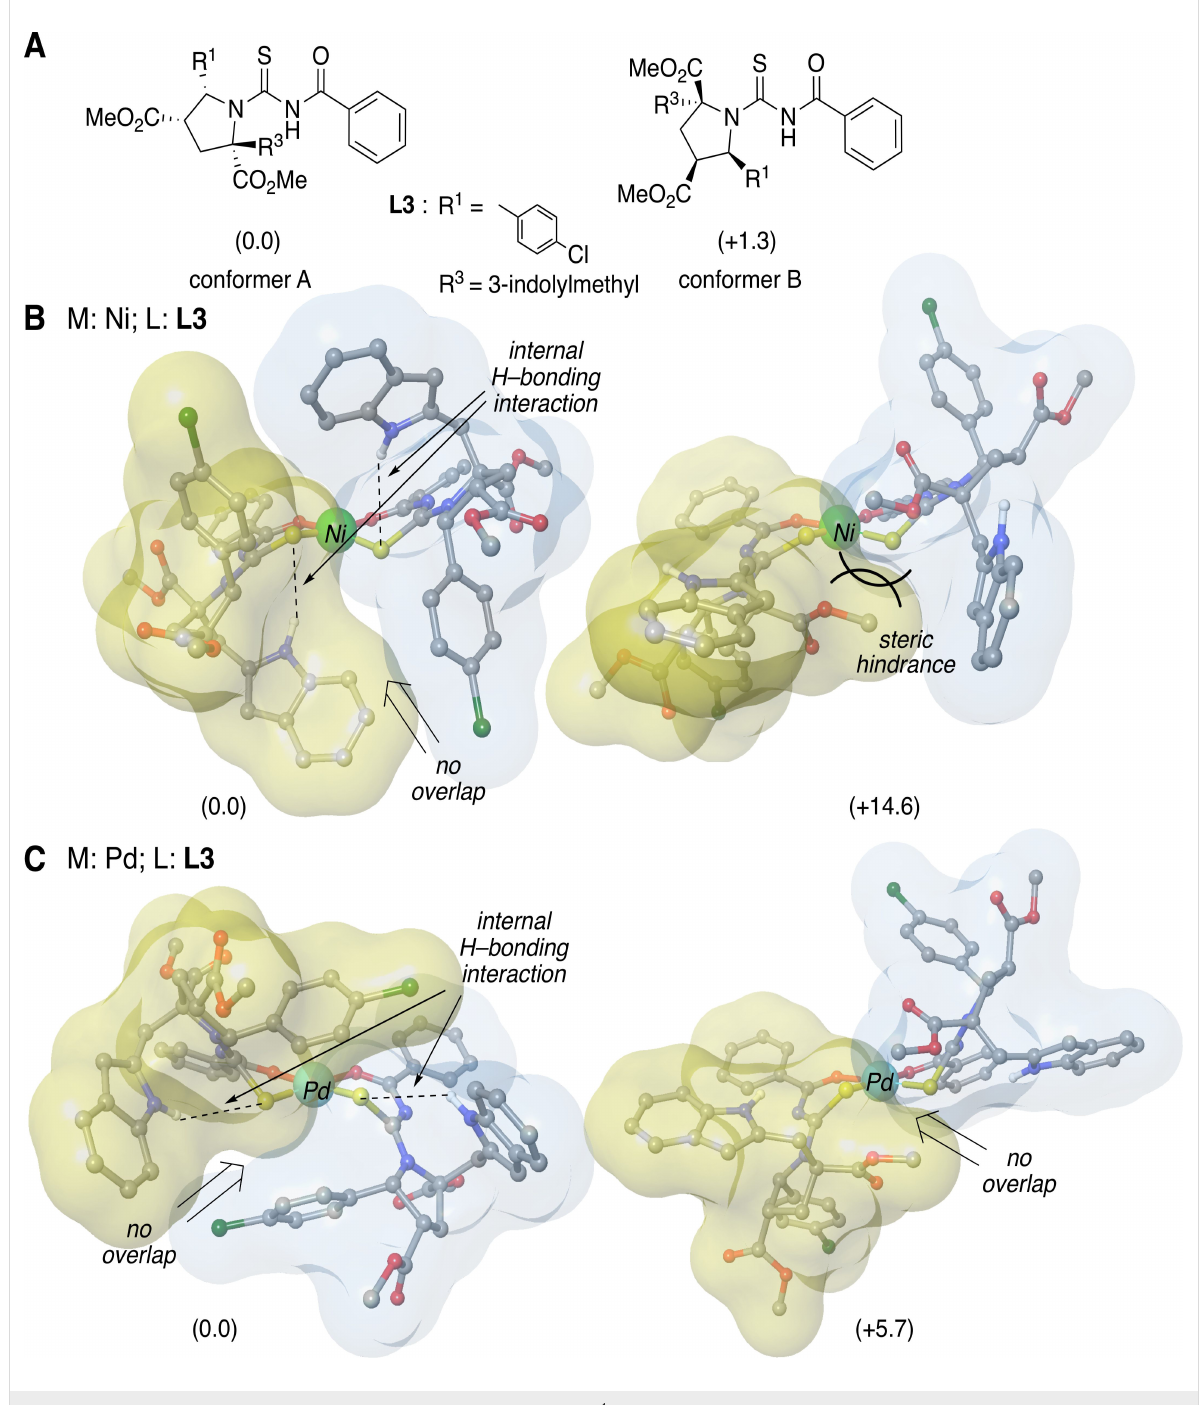
Figure 2: Main geometrical features and the relative energies (in kcal mol –1 ) of (A) ligand L3 , (B) nickel- and (C) palladium complexes. Blue and yellow surfaces represent the solvent accessible surface of ligands with a probe radius of 1.4 Å. Hydrogen atoms not involved on hydrogen–bonding interactions are omitted for